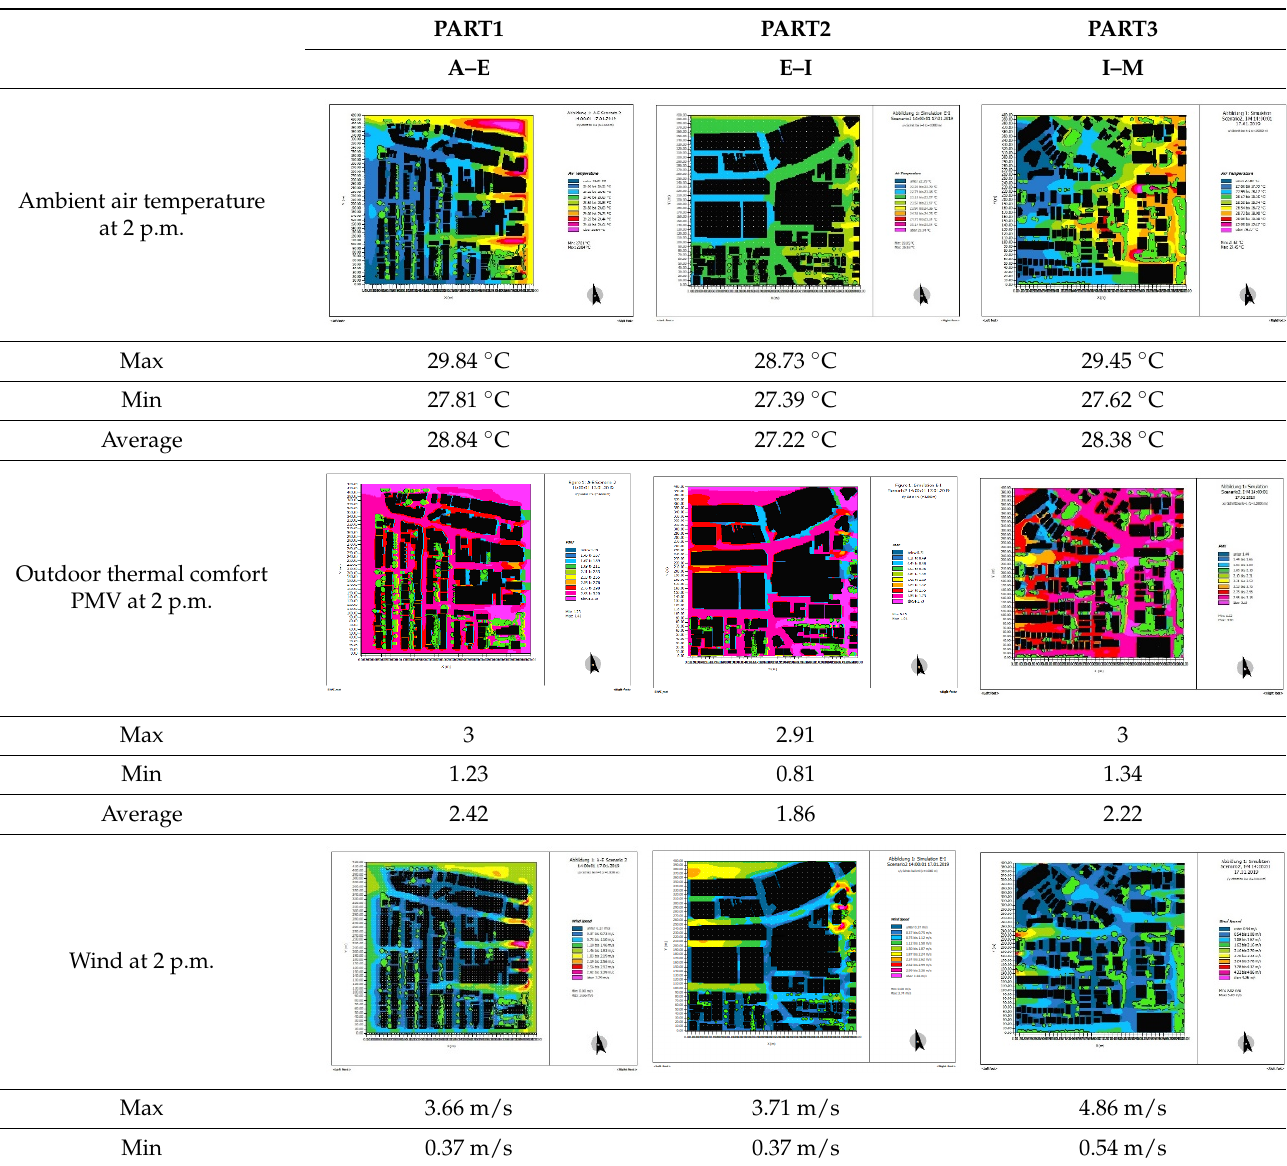
Table 9. Scenario two ambient air temperature, outdoor thermal comfort, and wind speed distribution maps in all parts at 2 p.m.